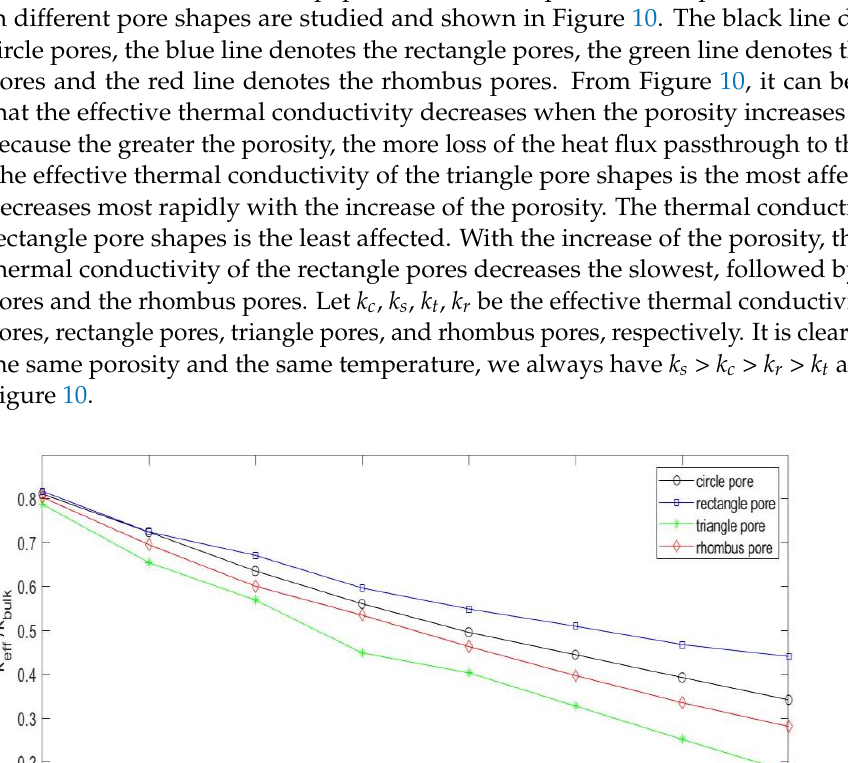
Figure 11. The effective thermal conductivity in square pores with different temperatures for AlAs.